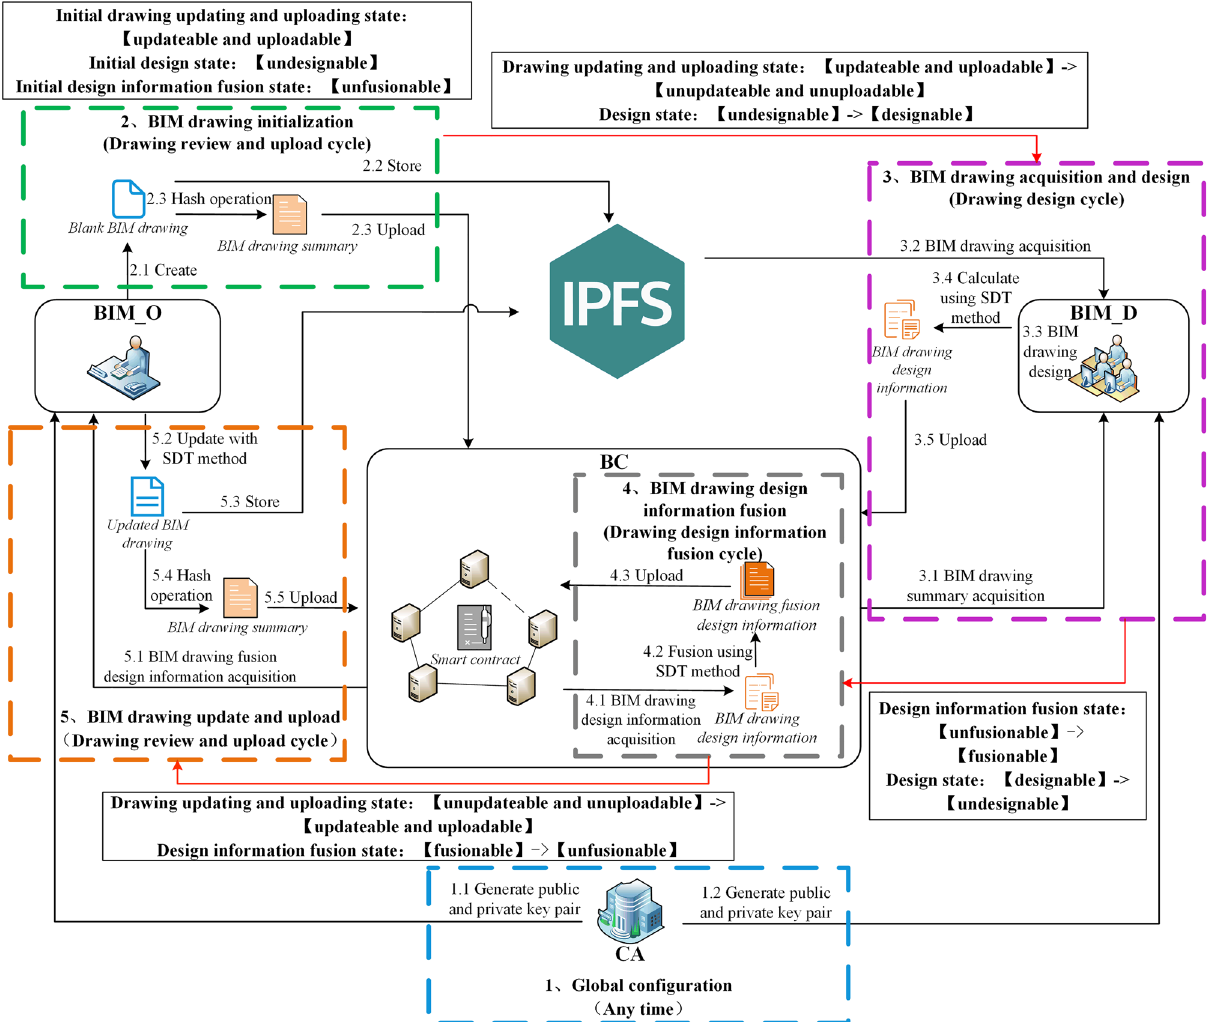
Figure 5. Blockchain-based BIM drawing multi-person collaborative design model running